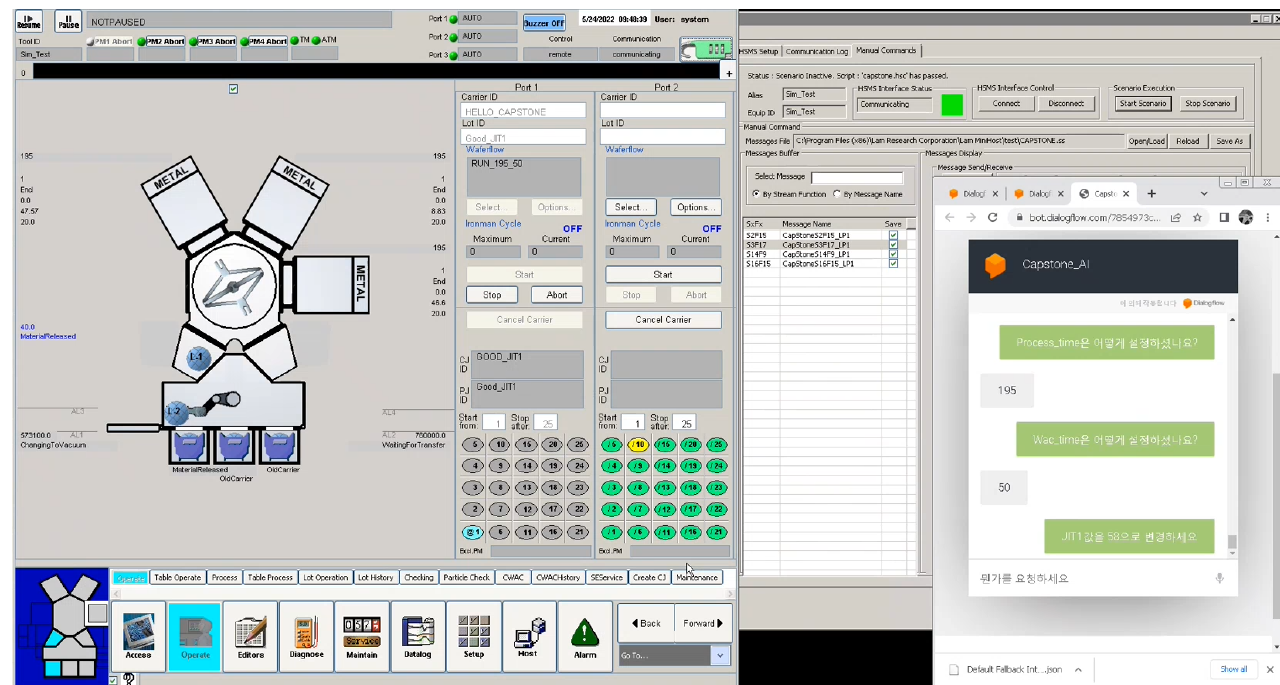
Figure 11. Optimal JIT1 value using chatbot